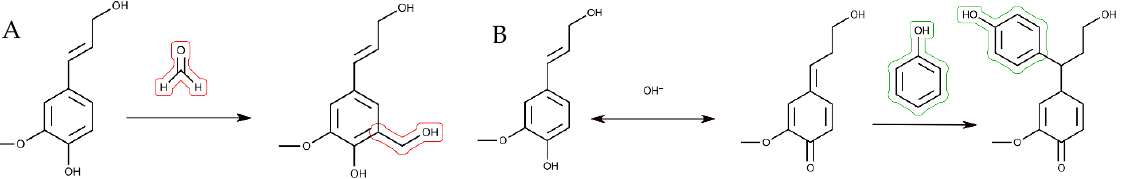
Figure 10. Proposed reaction mechanisms of lignin (represented as guaiacyl alcohol) with formaldehyde ( A ) and phenol ( B ).